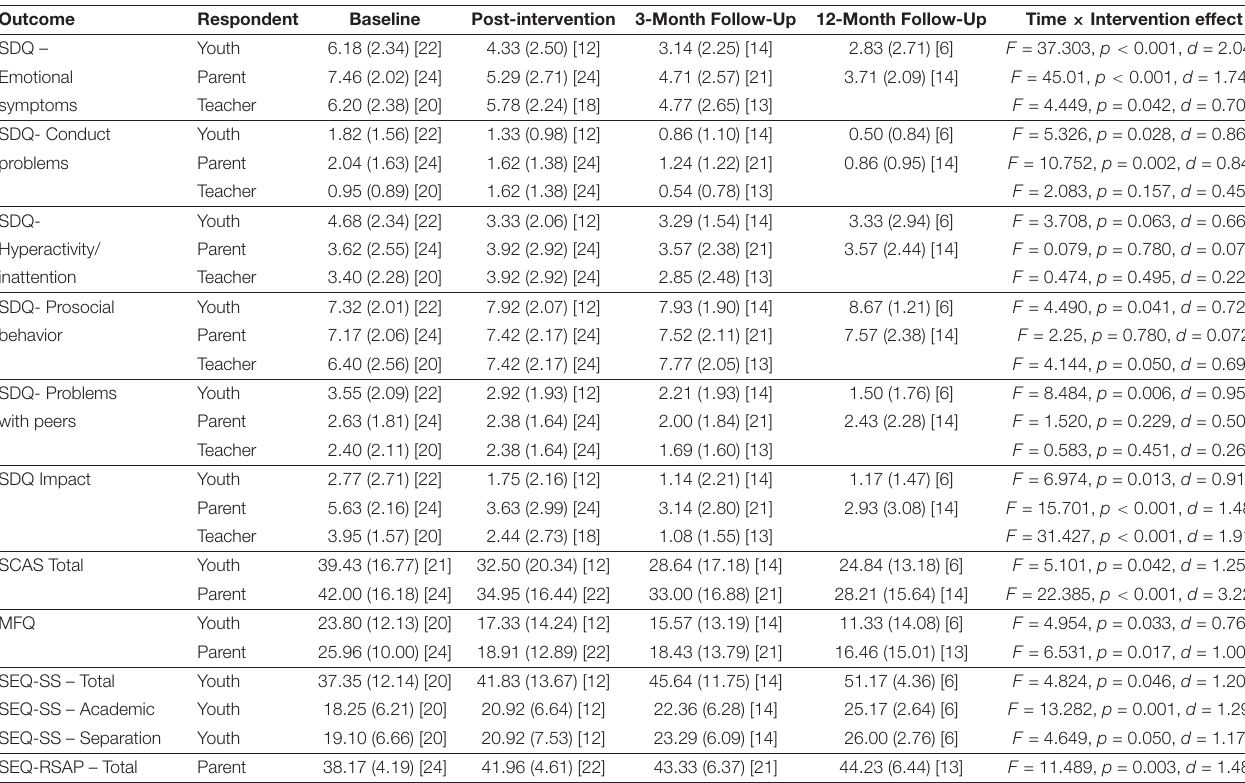
TABLE 5 | Outcomes and estimates of intervention